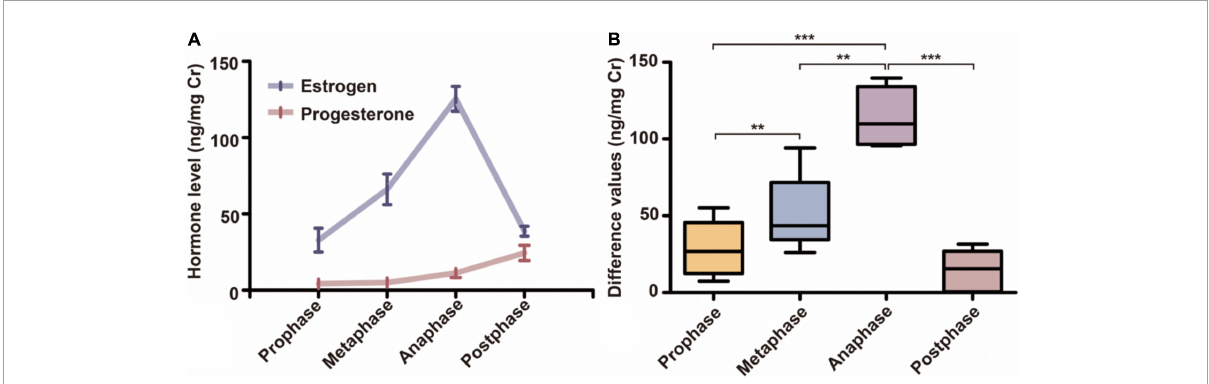
FIGURE1 The hormonal changes of female pandas during estrus. (A) The variations in urine estrogen and progesterone of female pandas during four different estrus periods ( n = 20). (B) The difference values between urinary estrogen and progesterone in female pandas changed during four different estrus periods ( n = 20). ** p < 0.01; *** p <